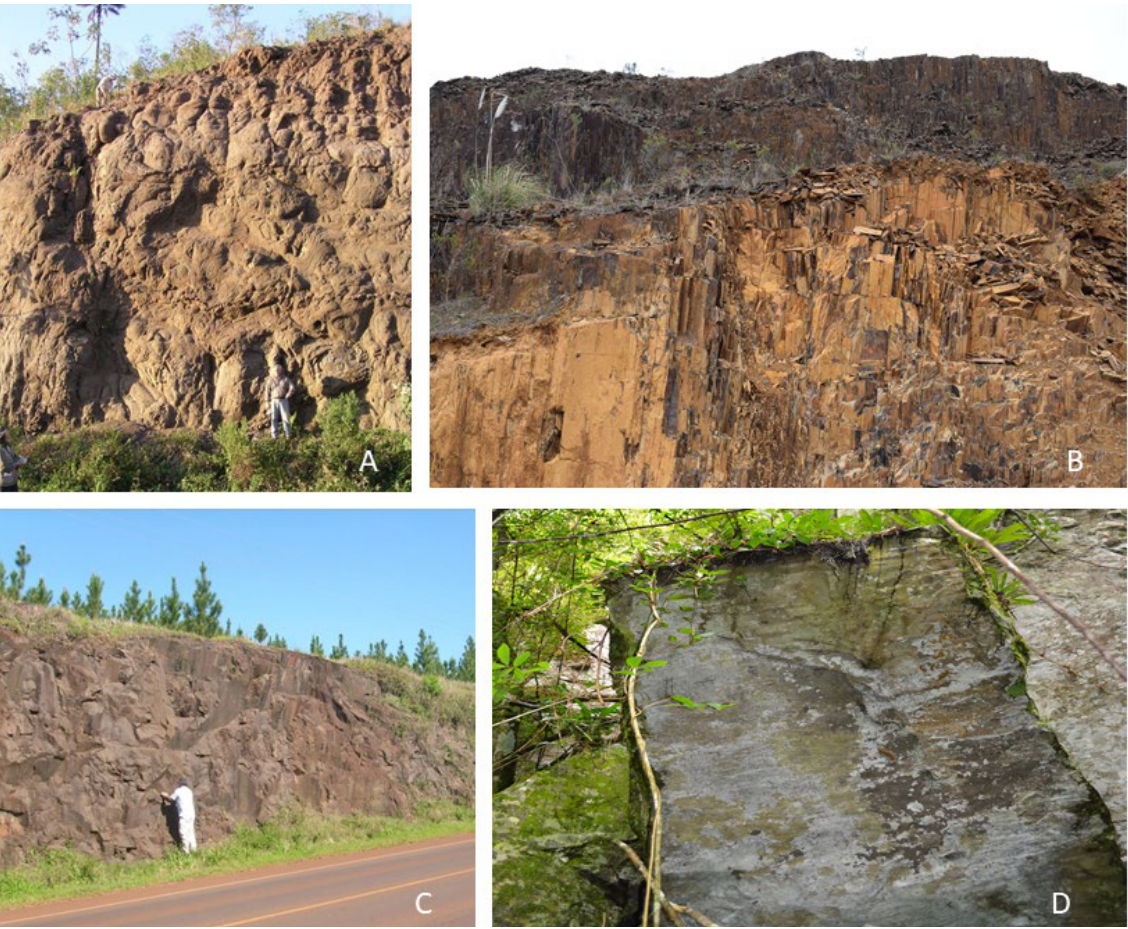
Figure 10. Basalt facies of the BSGC. A: Campo Erê facies. B: Cordilheira Alta facies (Painel County). C: Capanema facies. D: Campos Novos facies (Anita Garibaldi County). Photos A and C correspond to the province of Misiones (adjacent to the survey area) and have been selected because they better illustrate these two facies (both images are courtesy of Marcela Remesal and Silvia